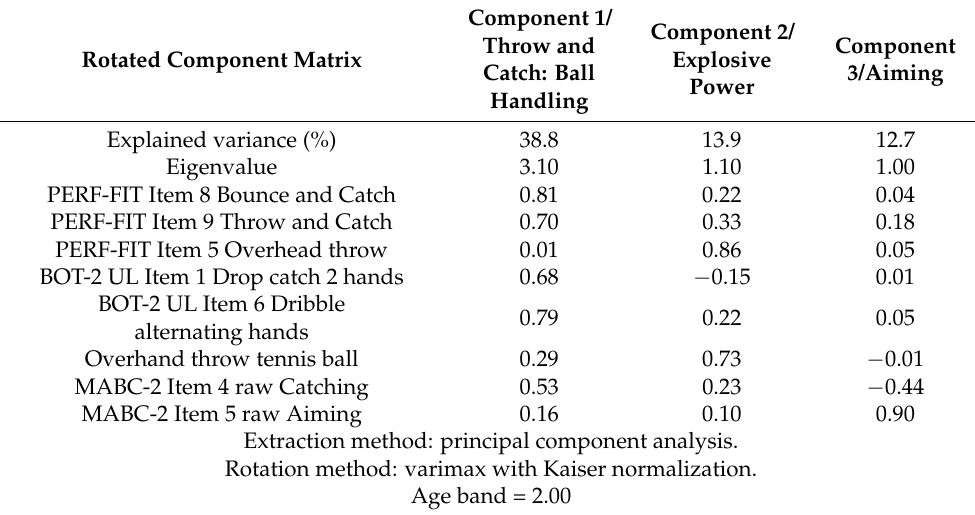
Table 5. Factor analysis for the different ball scales for children 7–10 years of age (n = 144). The highest factor loading of an item is shown in